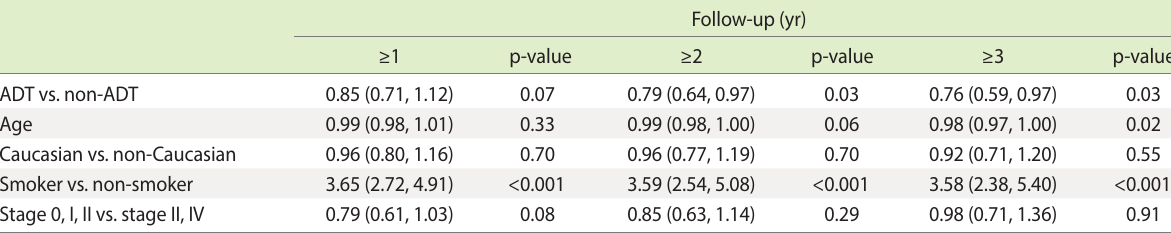
Table 2. Hazard ratios in various Cox regression models 1